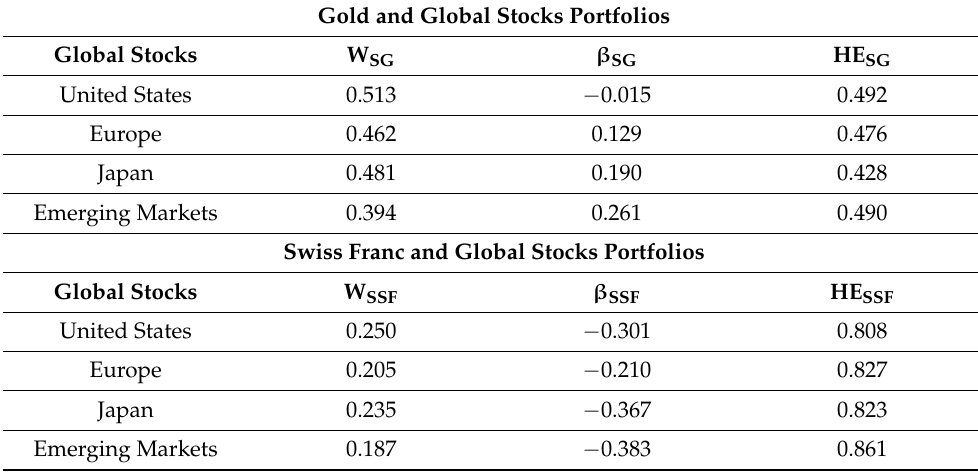
Table 4. Optimal Weights, Optimal Hedge Ratios, and Hedging Effectiveness; Average Values: 2000M11–2021M7 (249